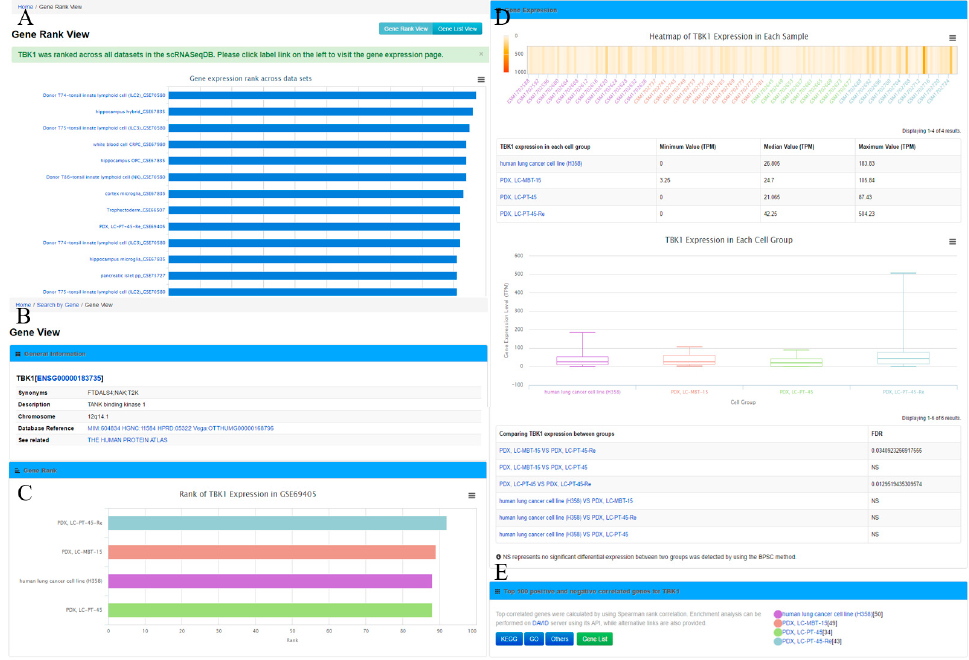
Figure 2. Gene Rank View and Gene View. ( A ) Gene rank list of an example gene TBK1 across all datasets; ( B ) Display general information of TBK1 in ‘Gene View’ page; ( C ) Show the gene rank of TBK1 in each cell group of GSE69405; ( D ) The section of gene expression displayed by heatmap and box plots. The minimum value, median value, and maximum value of the gene expression and the FDR (false discovery rate) of the gene expression comparison between groups are also displayed; ( E ) The top 100 positively and negatively correlated genes and annotation links are provided.